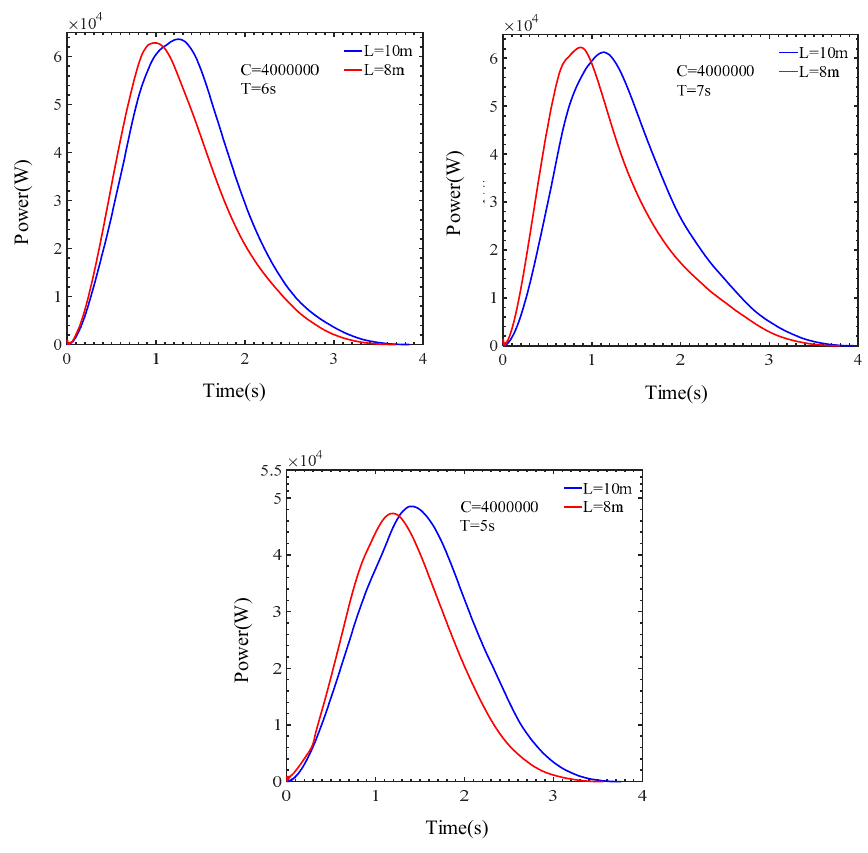
11 of 15 Table 2. Different flapping-panel length efficiency comparison. 𝑻/𝐬